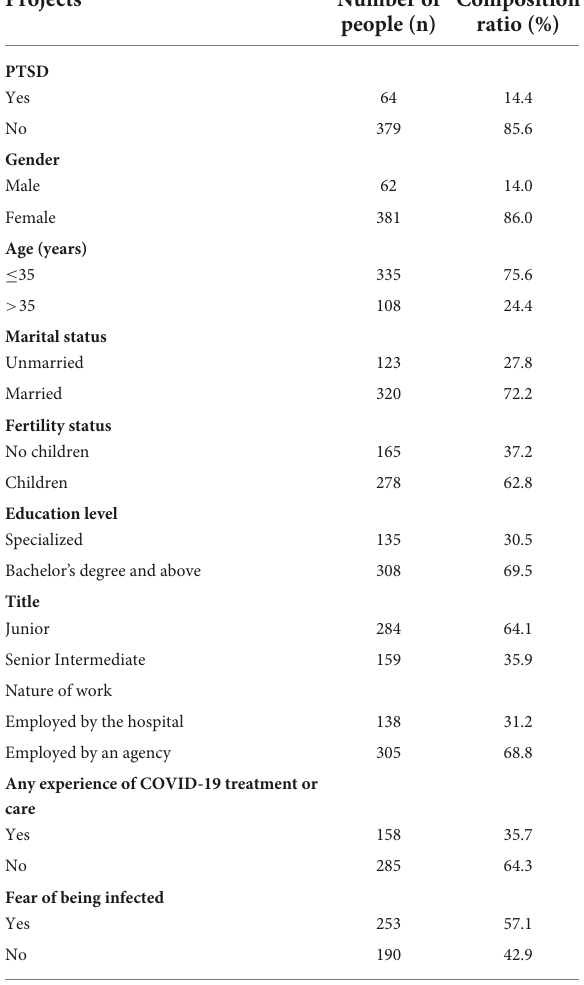
TABLE 1 General information on the study population ( n =